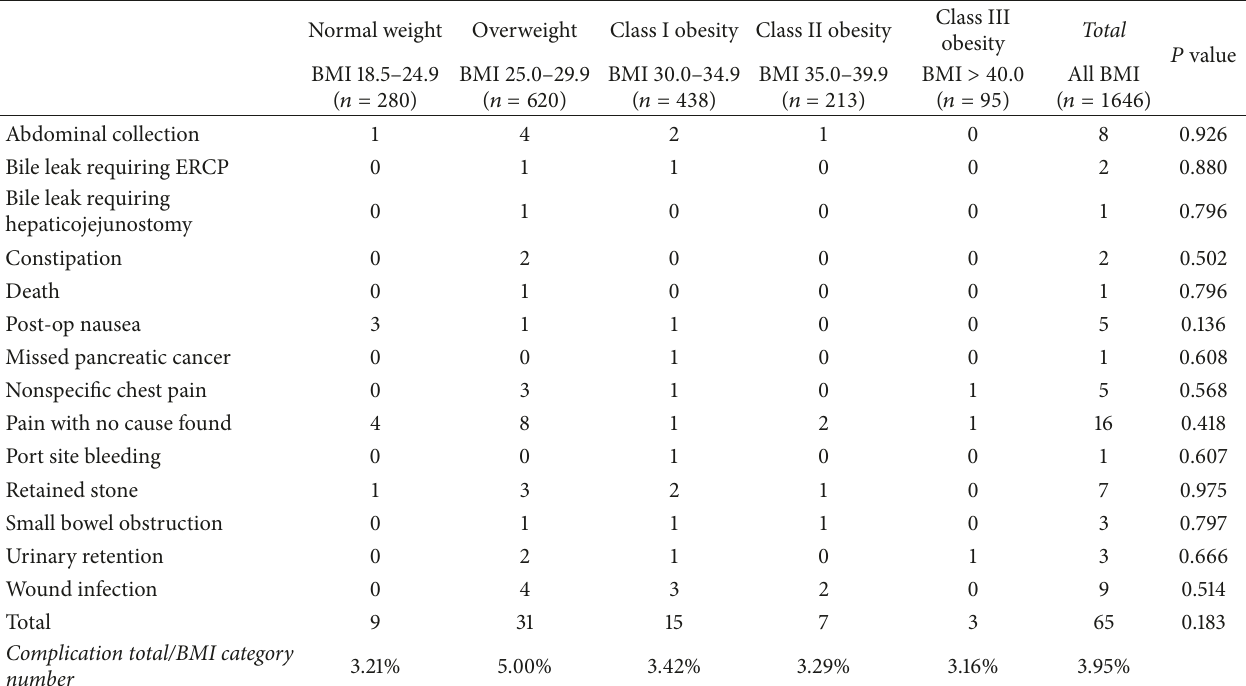
Table 5: Types of complication/readmission